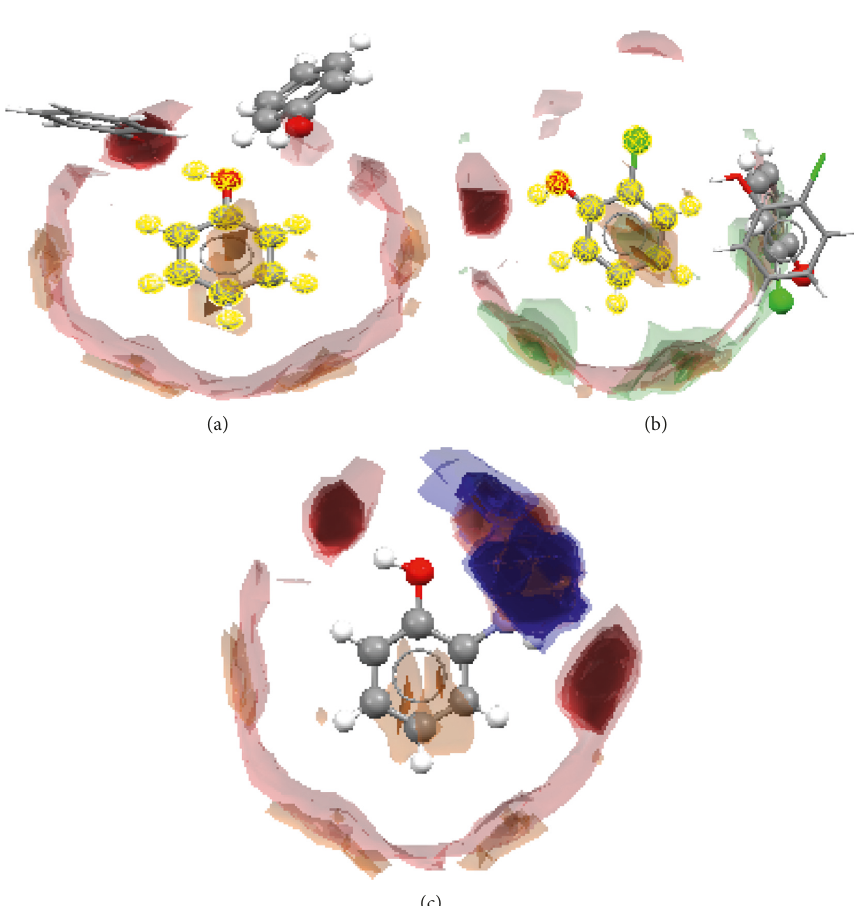
Figure 8: Full interaction maps of (a) phenol, (b) 2CPH, and (c)